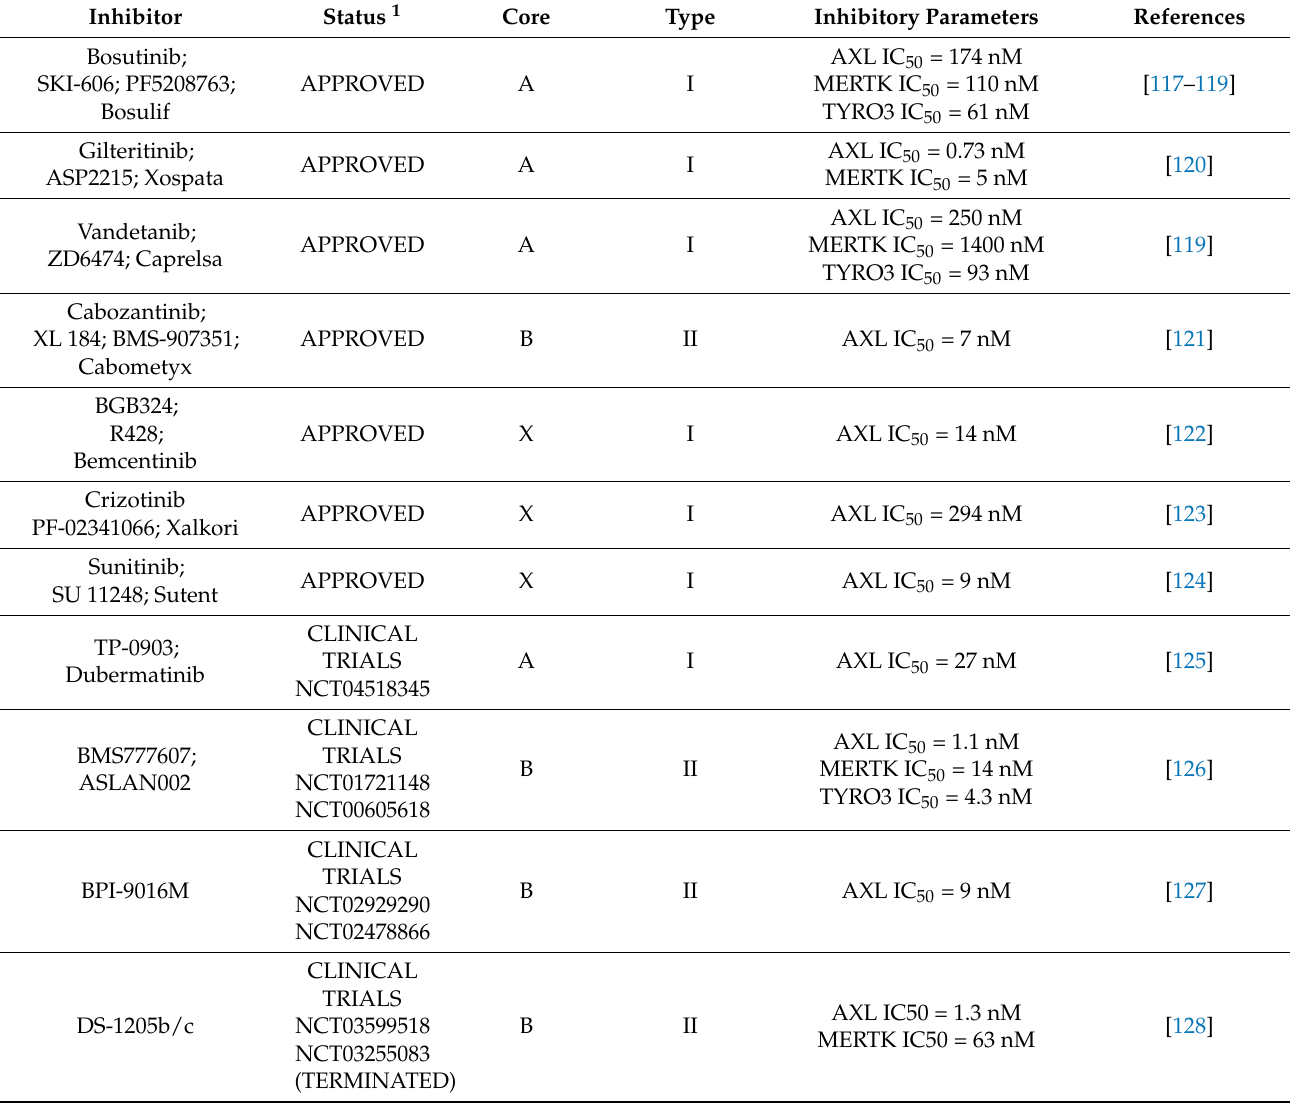
Table 1. TAM family kinase domain inhibitors in cancer